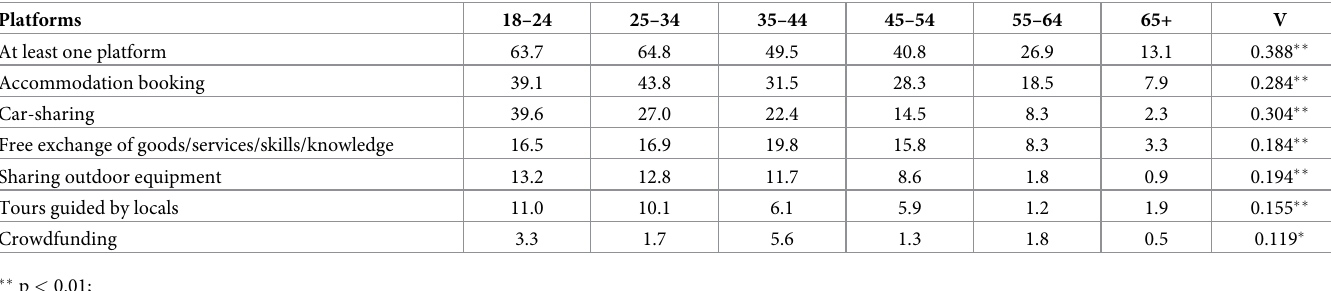
Table 4. Poles’ participation in the sharing platform services by age groups